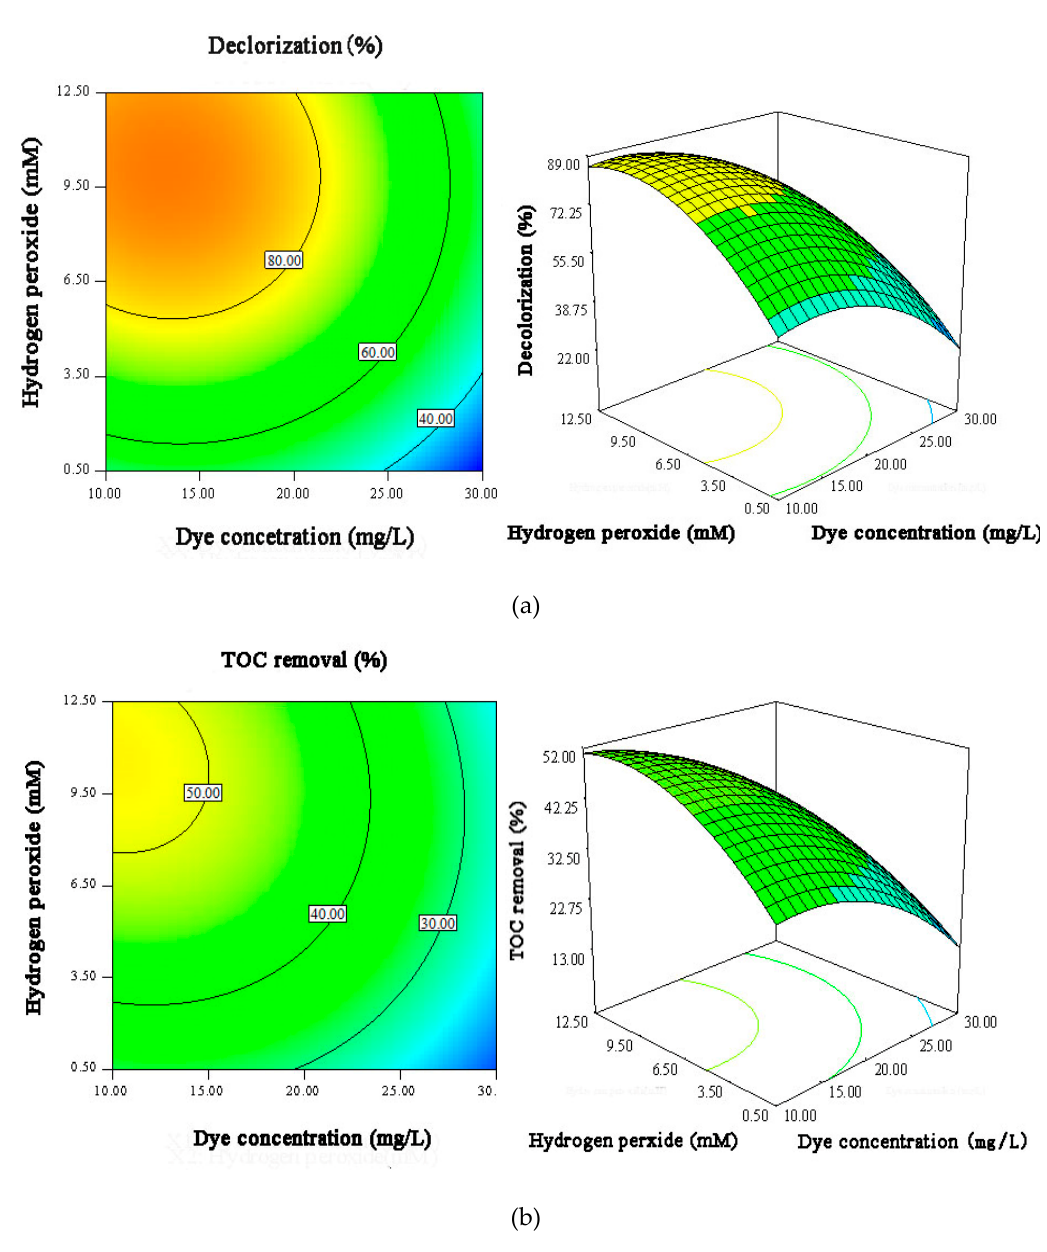
Figure 9. The contour plots and 3D surface responses for the e ff ects of initial H 2 O 2 concentration and MB concentration on MB decolorization e ffi ciency ( a ) and TOC removal e ffi ciency ( b